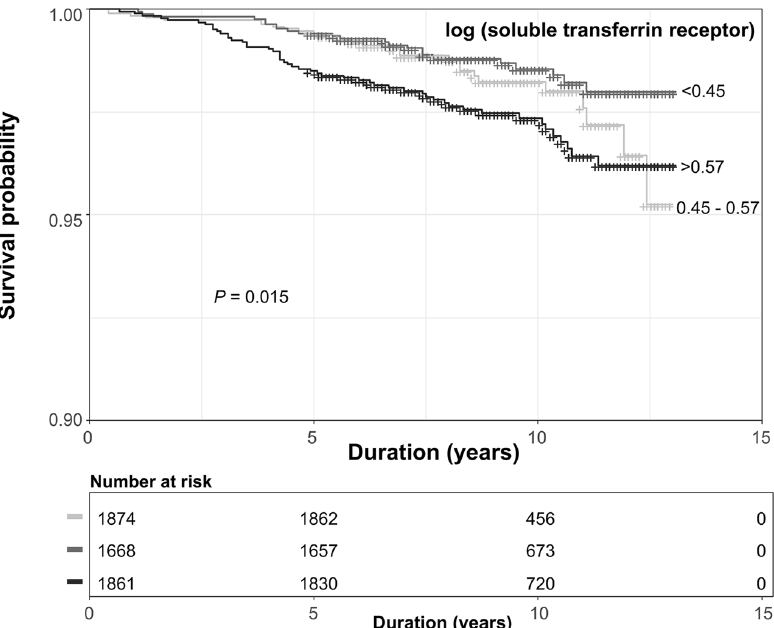
Figure 1. Cumulative survival curve according to tertile of log(soluble transferrin receptor). Kaplan–Meier curves showed that the highest tertile of log(soluble transferrin receptor) had the lowest survival probability for all-cause